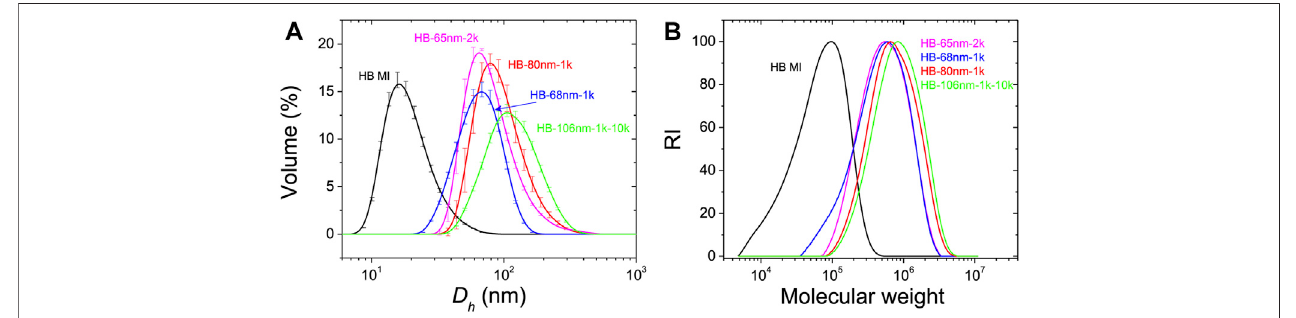
TABLE 1 | Structural information for the HB MI and HB PEO synthesized in this work.